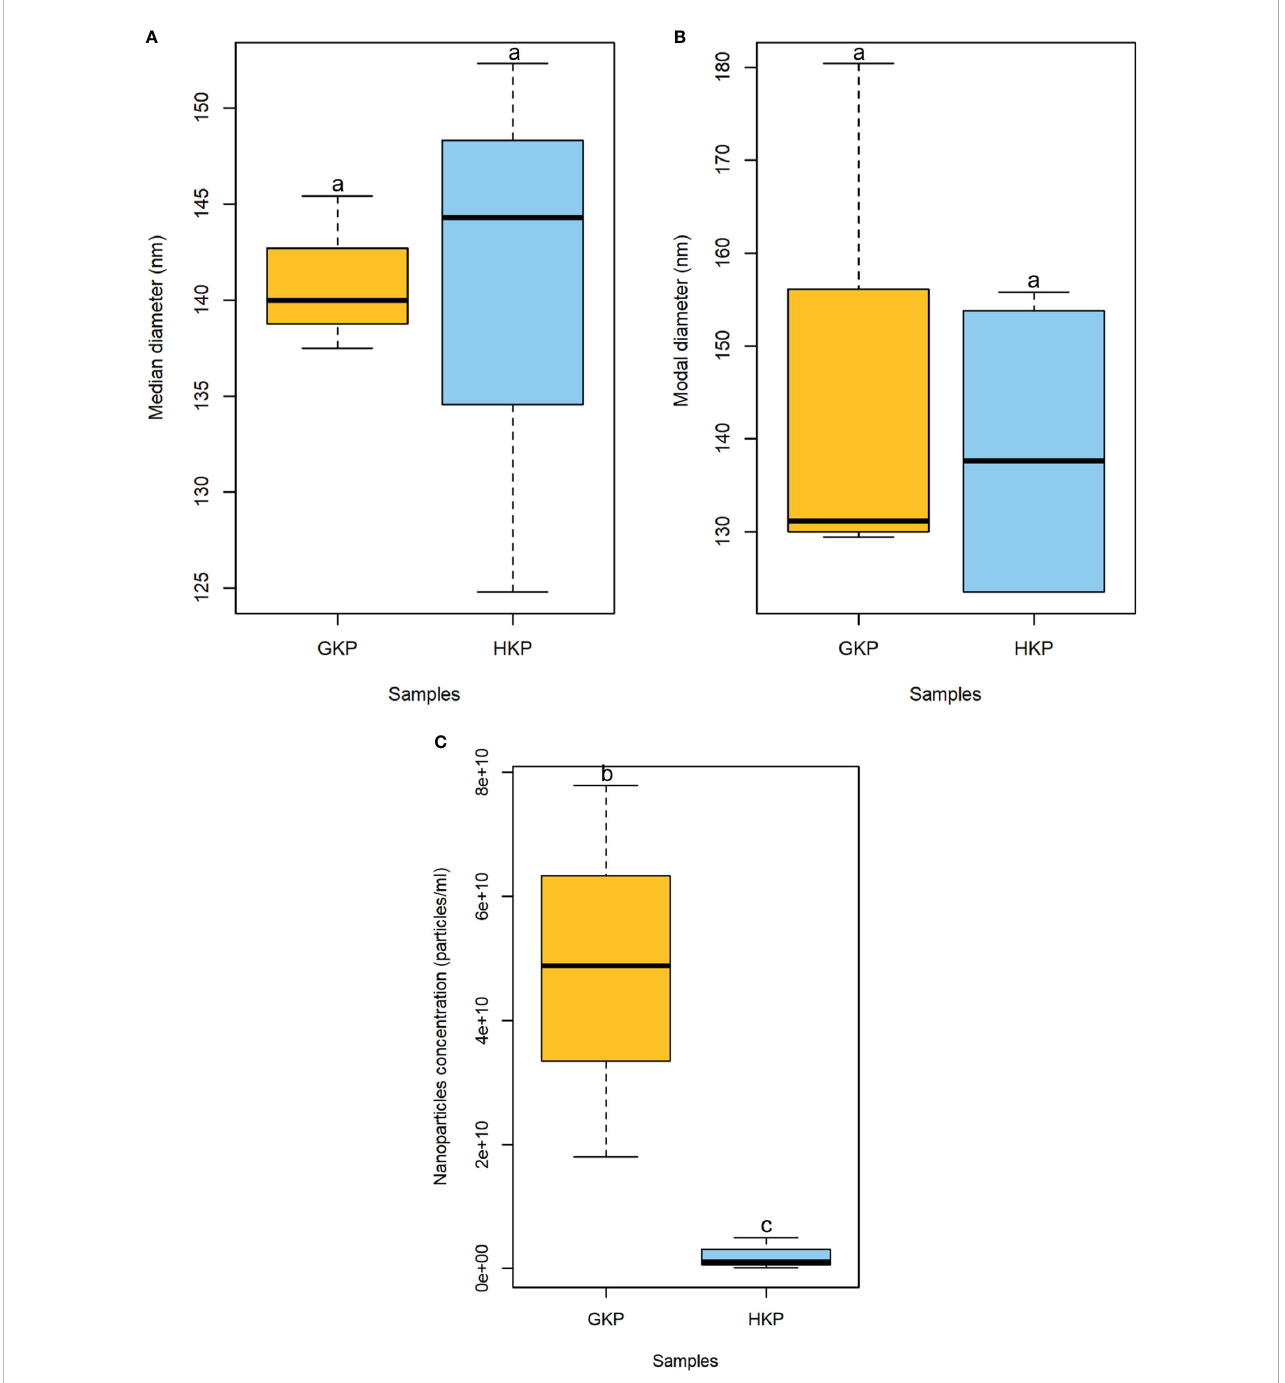
FIGURE 1 Boxplot representation (± SD) of median (A) and modal (B) diameters (nm), and concentration (particle/mL) (C) of nanoparticles in EVs fractions from GKP and HKP. Samples with different superscript letters differed with a weak signi fi cance (p-value<0.1) by one-way